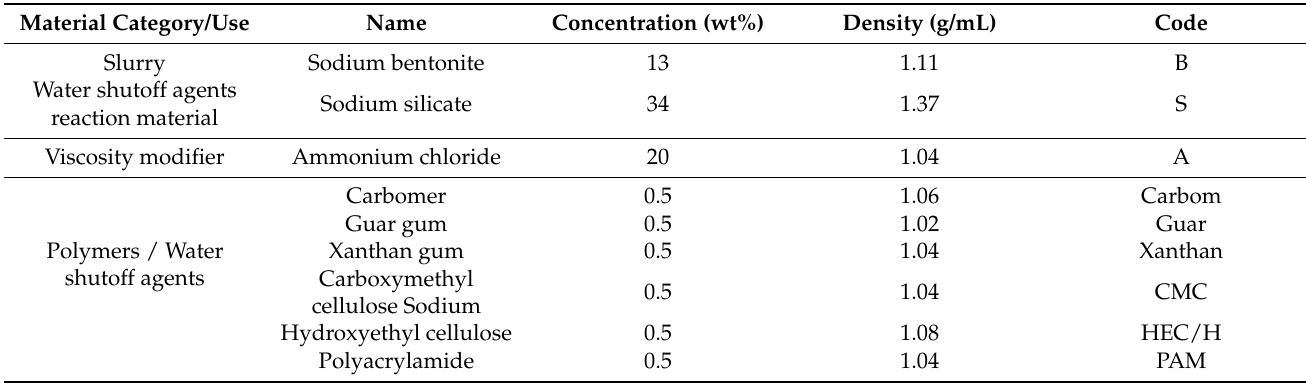
Table 3. Experimental